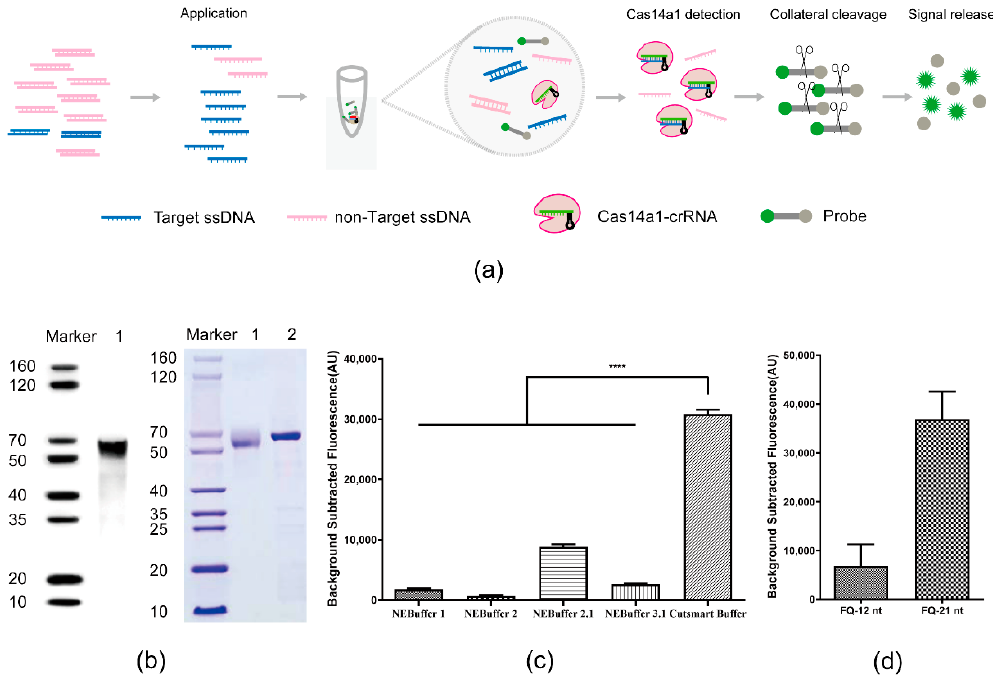
Figure 1. Cas14a1 Fluorescence Detection System. ( a ) Schematic of Cas14a1 fluorescence detection system. ( b ) Identification of Cas14a1 protein after purification: left, identification of Cas14a1 by Western blotting; right, Cas14a1 purity assessed using SDS-PAGE; BSA: control (lane 1). ( c ) Comparison of fluorescence signals obtained using different buffer candidates; **** p < 0.0001. ( d ) Comparison of fluorescence signals obtained using different lengths of FQ probe: FQ-12nt, length of FQ probe = 12 nt; FQ-21nt, length of FQ probe = 21 nt.